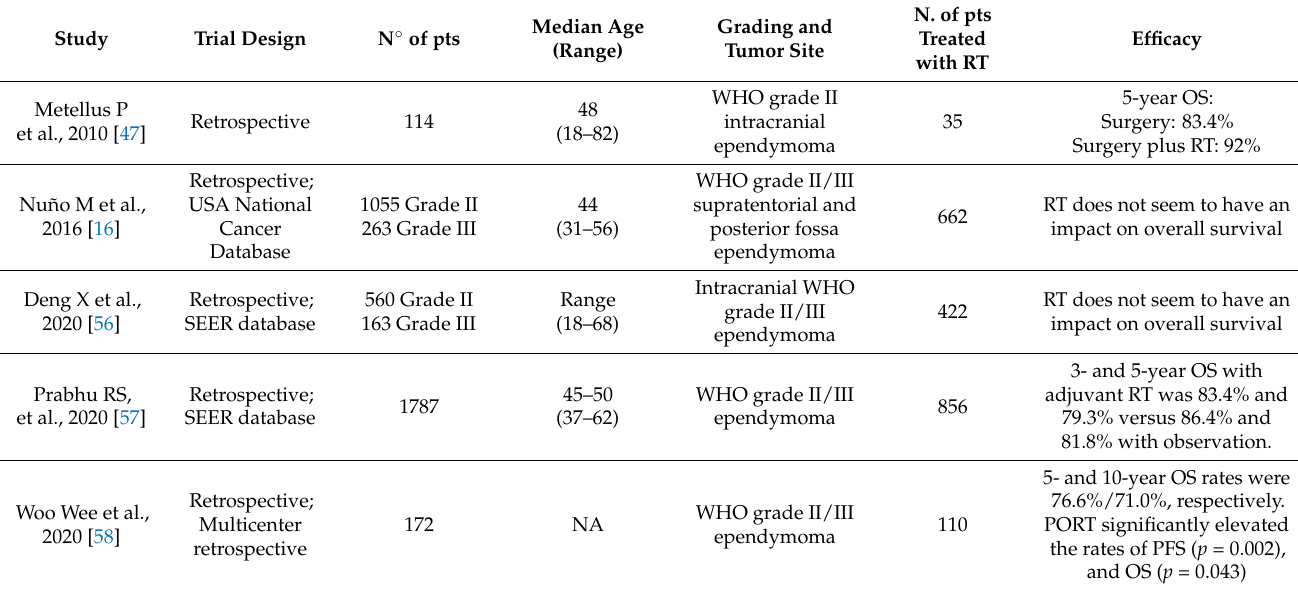
Table 3. Most relevant studies investigating the role of RT in ependymal tumors. RT = radiation therapy; PFS = progression- free survival; OS = overall survival; NA = not available; pts =